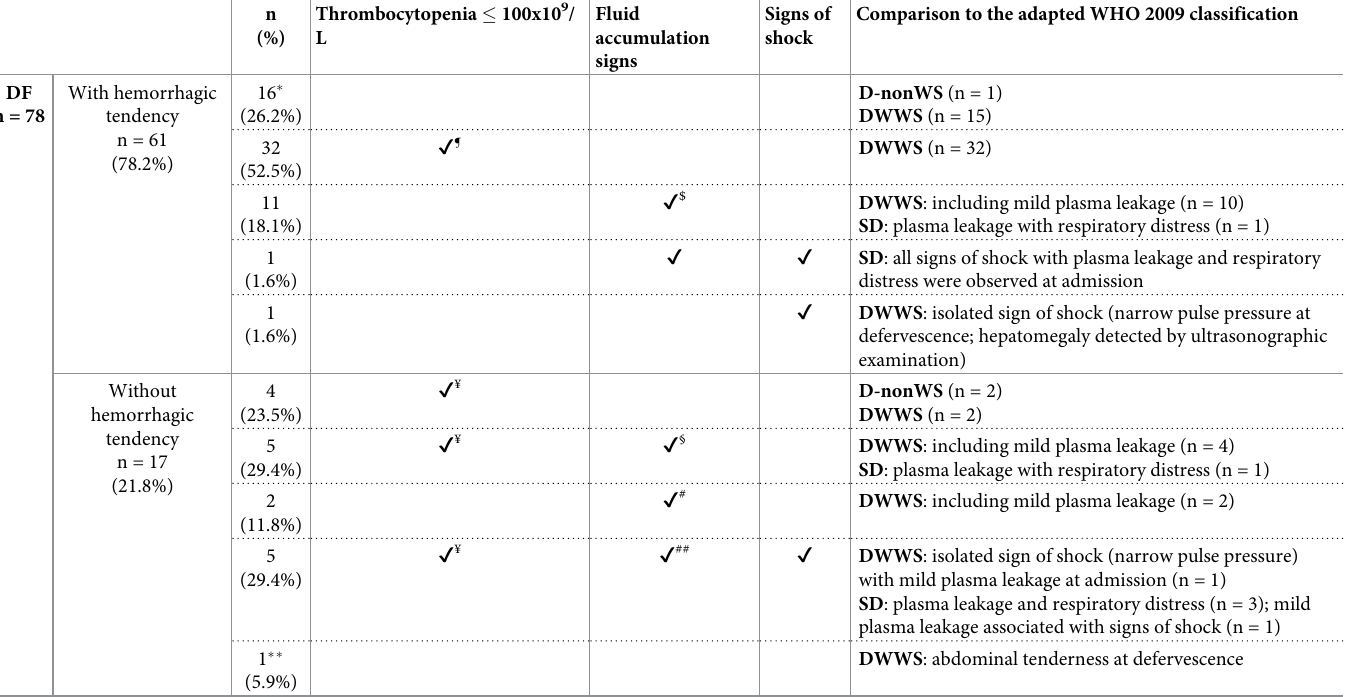
Table 4. Description of hemorrhagic and shock clinical manifestations presented by laboratory-confirmed dengue patients classified as DF (n = 78) using the WHO 1997 case definition, with comparison to the adapted WHO 2009 dengue classification. n Thrombocytopenia � 100x10 9 / L (%) DF With hemorrhagic n = 78 tendency n = 61